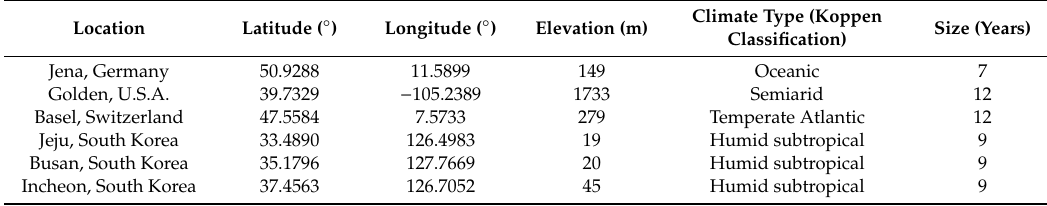
Table 2. Datasets locations and climate